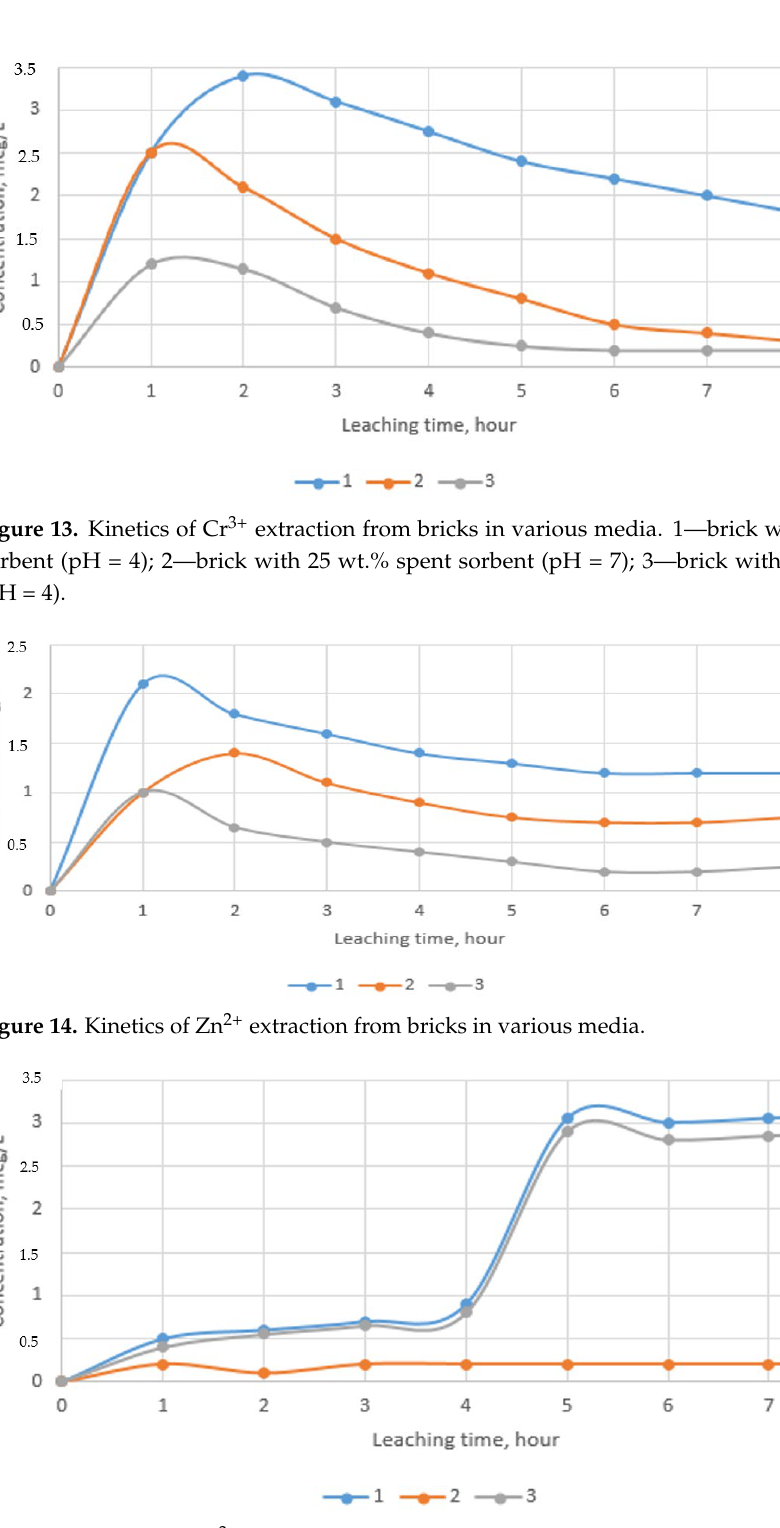
Figure 15. Kinetics of Fe 3+ extraction from bricks in various media.